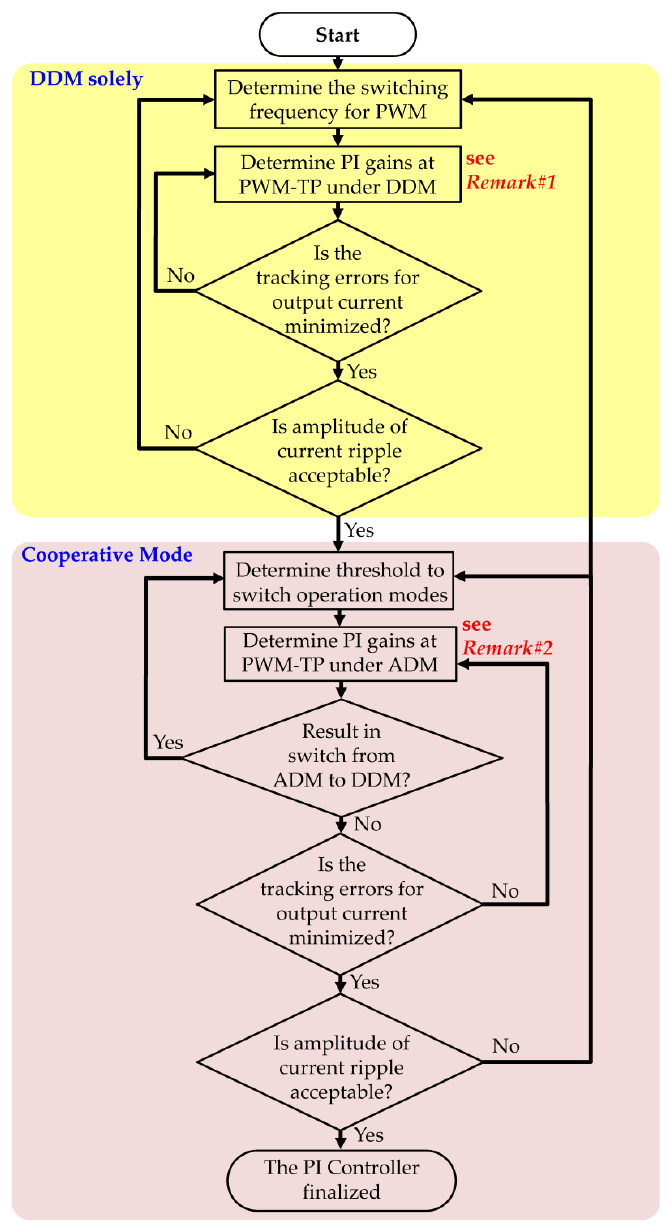
Figure 5. Design procedure of PWM-TPs (pulse width modulation-tuning processors).